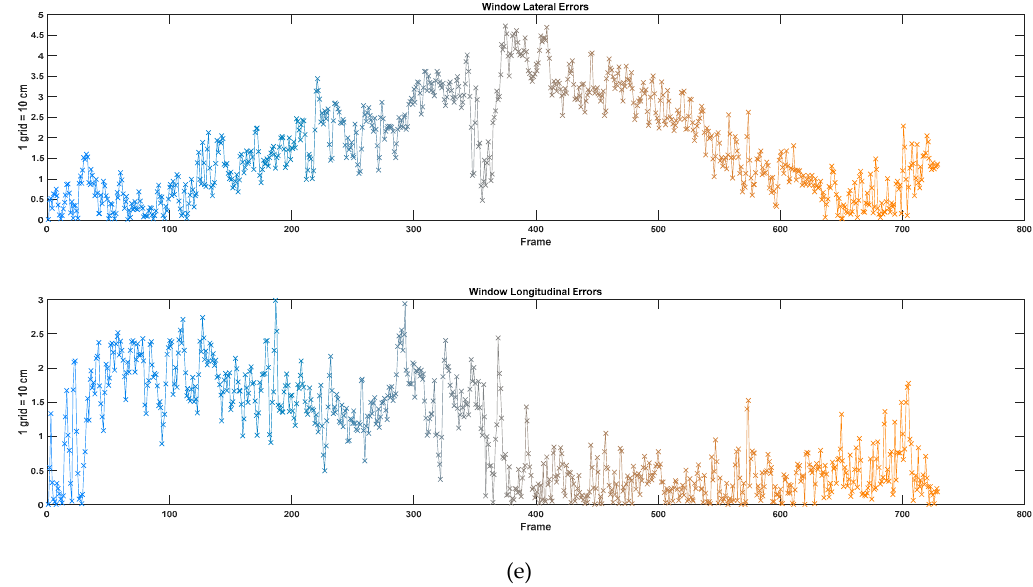
Figure 17. Comparison of the Window and SLAM trajectories. ( a ) Window trajectory. ( b ) Local magnification of the trajectory (start and end section). ( c ) Local magnification (middle section). ( d ) Local magnification (U-turn around the landmark). ( e ) Lateral and longitudinal errors between the Window and SLAM trajectories.